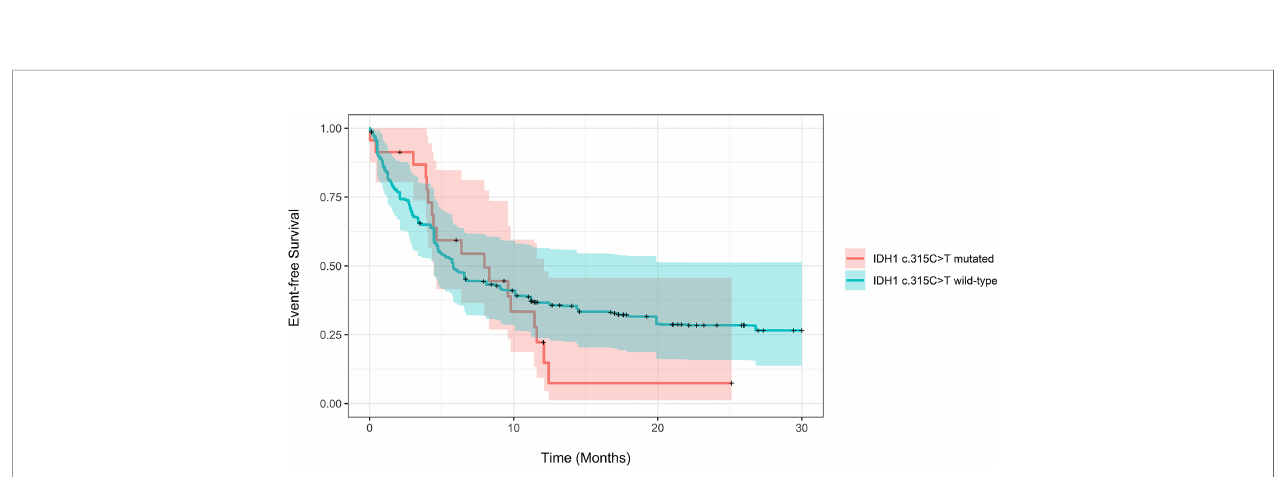
FIGURE 2 | Propensity score-adjusted Event-free Survival for patients with IDH1 c.315C>T mutated vs. IDH1 wild-type AML. Log-Rank adjusted P-Value was non- signi fi cant (P =